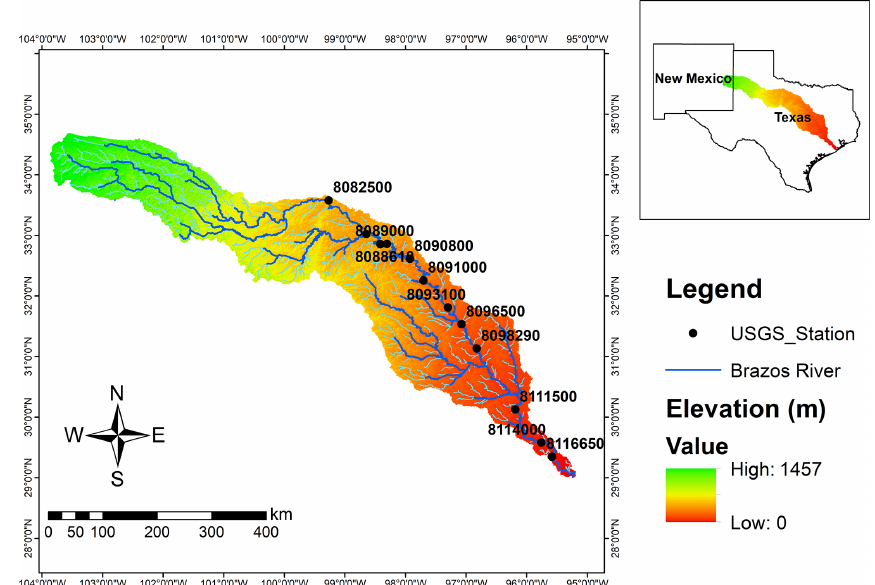
Figure 3. Brazos streamflow network and USGS stream gauges’ locations.